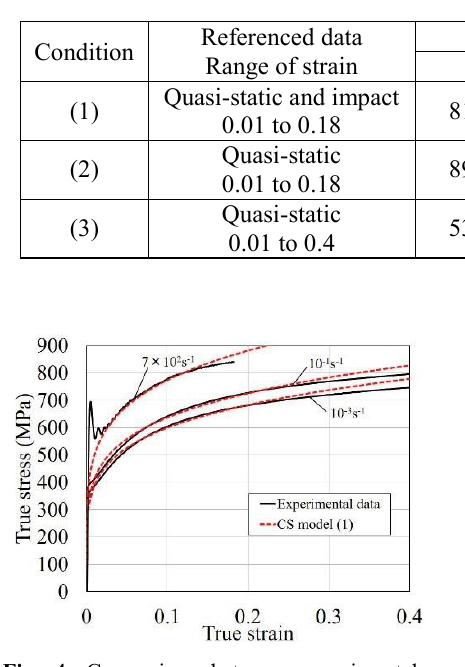
Fig. 5. Comparison between experimental results and CS model with referenced by the only quasi-static test in stress-strain relations of SM490B.